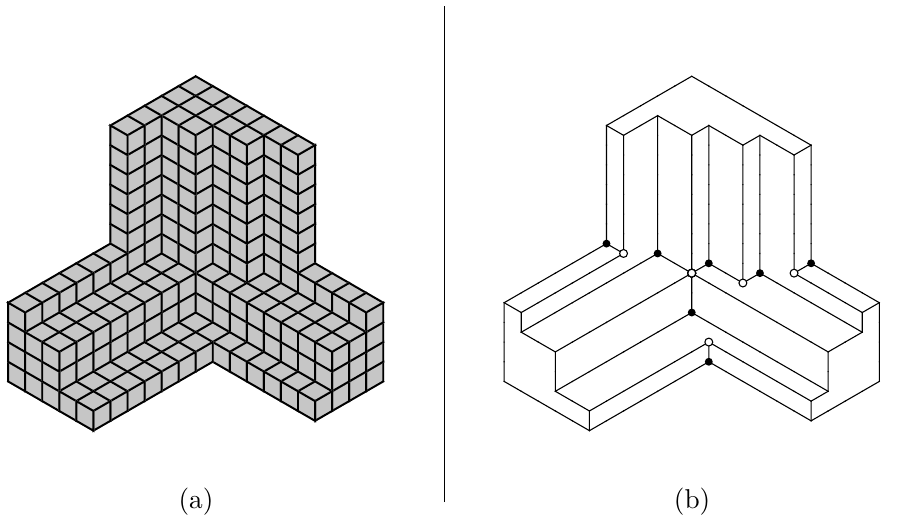
Figure 9 . For plane partition representation with asymptotics Y 1 = { 4 , 3 , 3 , 1 , 1 } , Y 2 = { 4 , 3 , 3 , 1 } , Y 3 = { 7 , 5 , 3 , 1 , 1 } , the ground state configuration (a) and the graph D ~